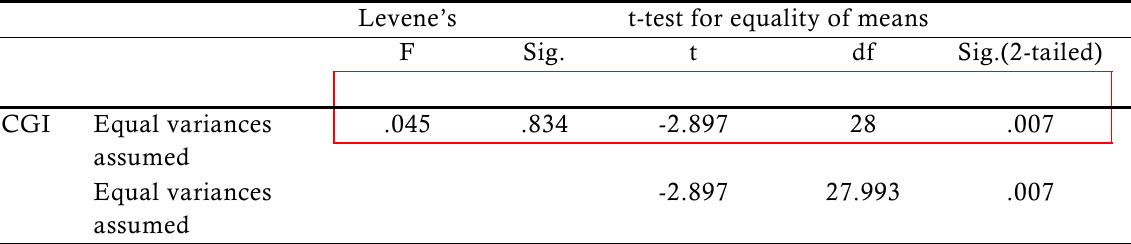
Table 5. Results of independent t-test of